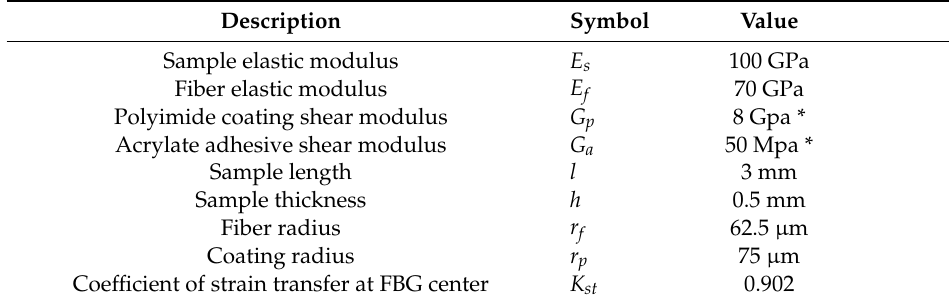
Figure 11. Schematics of a model to estimate the strain transfer ( a ) Cross-section of fiber plus sample ensemble for strain measurement. Here h is the sample thickness, r p is the coating radius, r f is the fiber cladding radius. ( b ) Fiber top view, indicating the sample length l , with respect to FBG position. ( c ) Strain transfer coefficient K st plotted as a function of position x on the fiber, computed using Equation (3) with parameters in Table 1. Table 1. Physical quantities and dimensions used for the computation of the strain transfer coefficient K st in Figure 11.